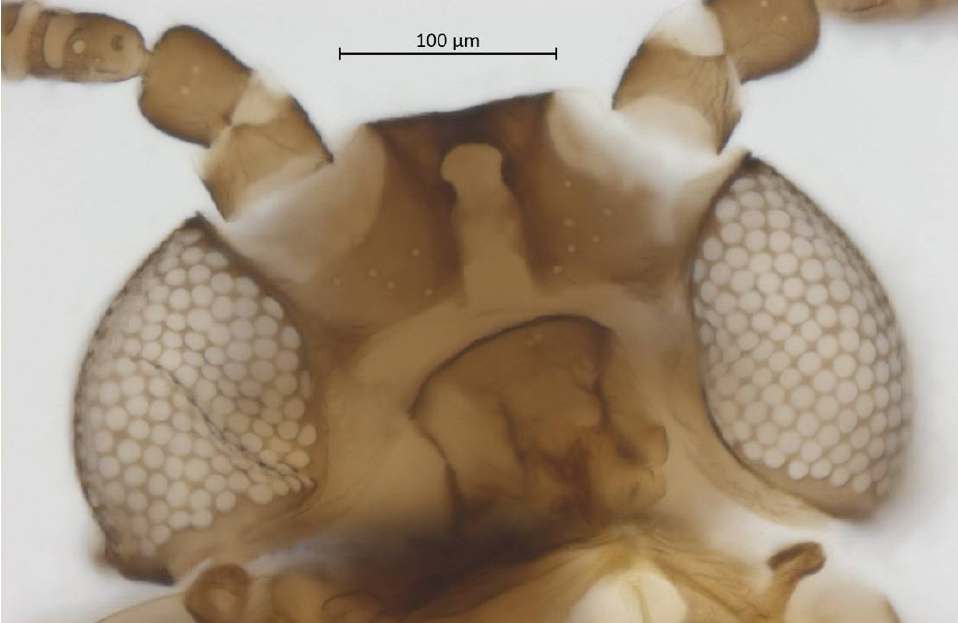
Figure 4. Ventral head of alate vivipara holotype of Qiao jinshaensis sp. nov. (IOZ(E)54809).